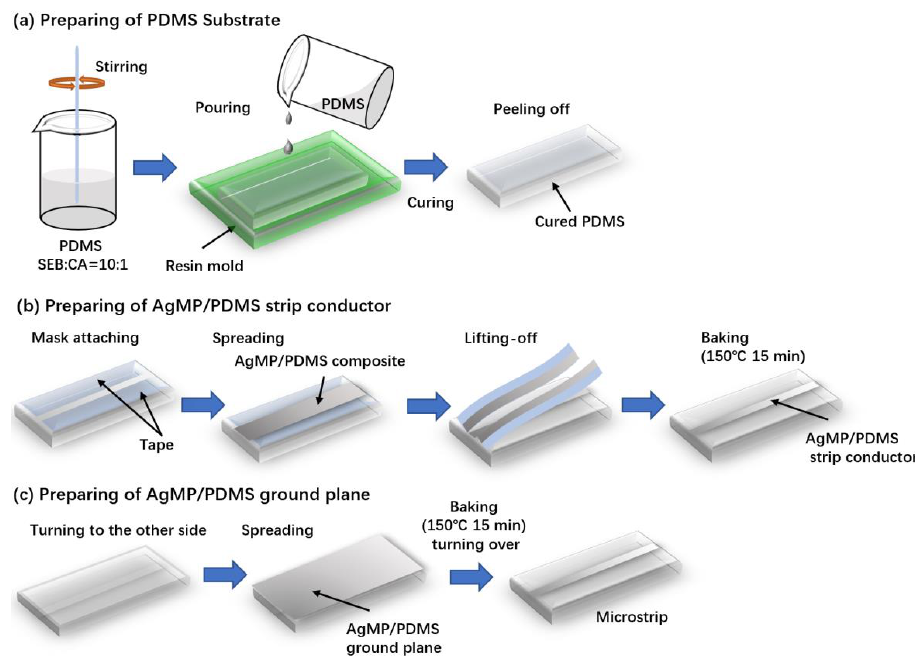
Figure 2. The fabrication process of the proposed microstrip. Preparing of ( a ) PDMS substrate, ( b ) Ag microparticles/PDMS (AgMP/PDMS) strip conductor, ( c ) AgMP/PDMS ground